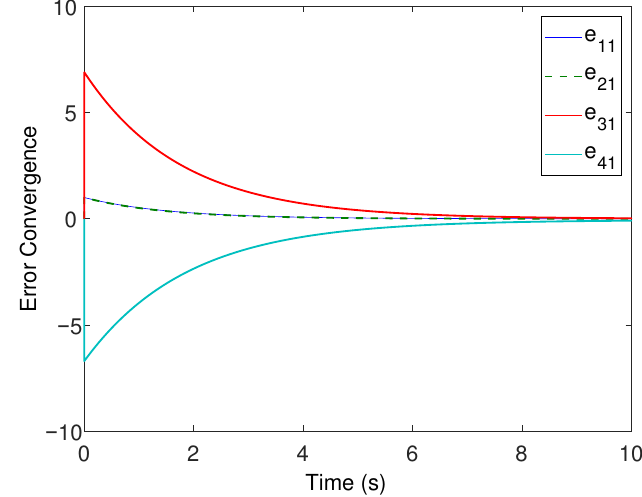
Figure 5. Position errors’ convergence.